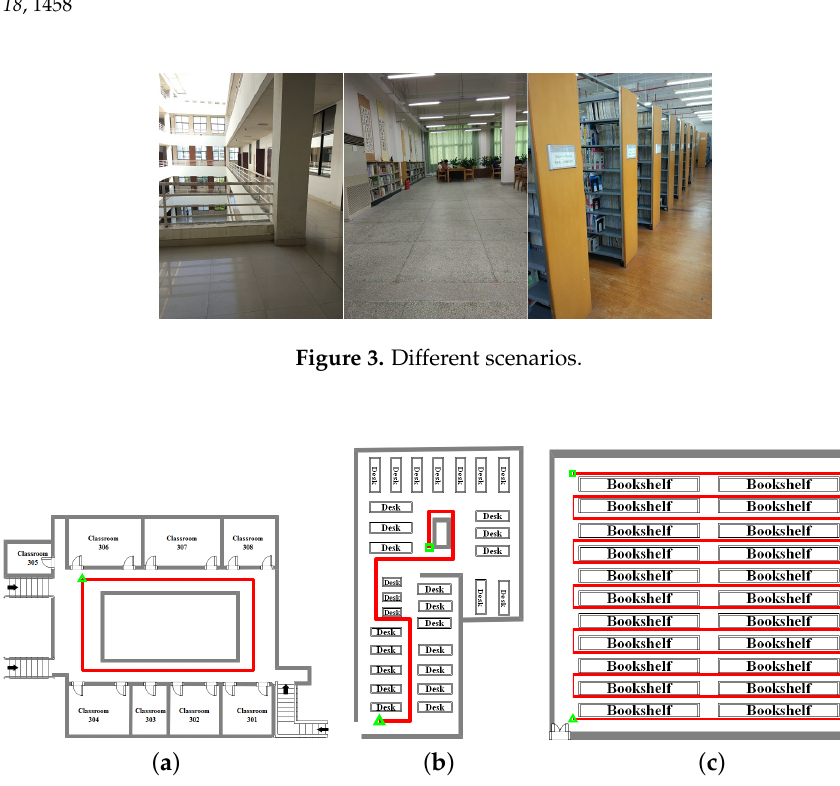
Figure 4. The walking trajectory: ( a ) corridor; ( b ) study room; and ( c ) library stack room.